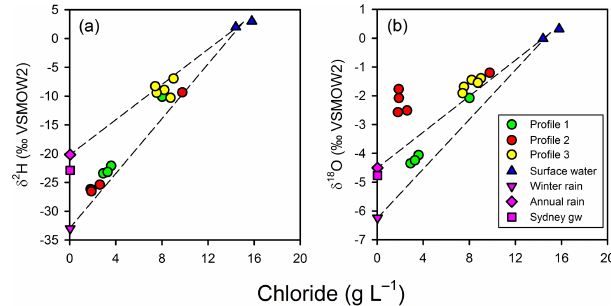
Figure 7. Chloride-based mixing lines for the isotopic composition of porewater relative to surface water and annual Sydney rainfall or winter Sydney rainfall. Sydney rainfall and groundwater were used Figure 8. Isotopic composition for surface water, porewater, and as proxies for the isotopic composition of un-impacted groundwater Sydney groundwater and rainfall relative to the meteoric water line at the site. Profile 2 porewater δ 18 O H values cannot be readily 2 O for Sydney (Lucas Heights; solid line). Dashed lines represent po- accounted for by a two-endmember conservative mixing model for tential mixing lines between terrestrial groundwater and surface terrestrial groundwater and surface water. water. Note that evaporation lines for groundwater would be very similar to the mixing line in this environment. Profile 2 porewater samples do not conform to a two-endmember conservative mixing model between terrestrial groundwater and surface